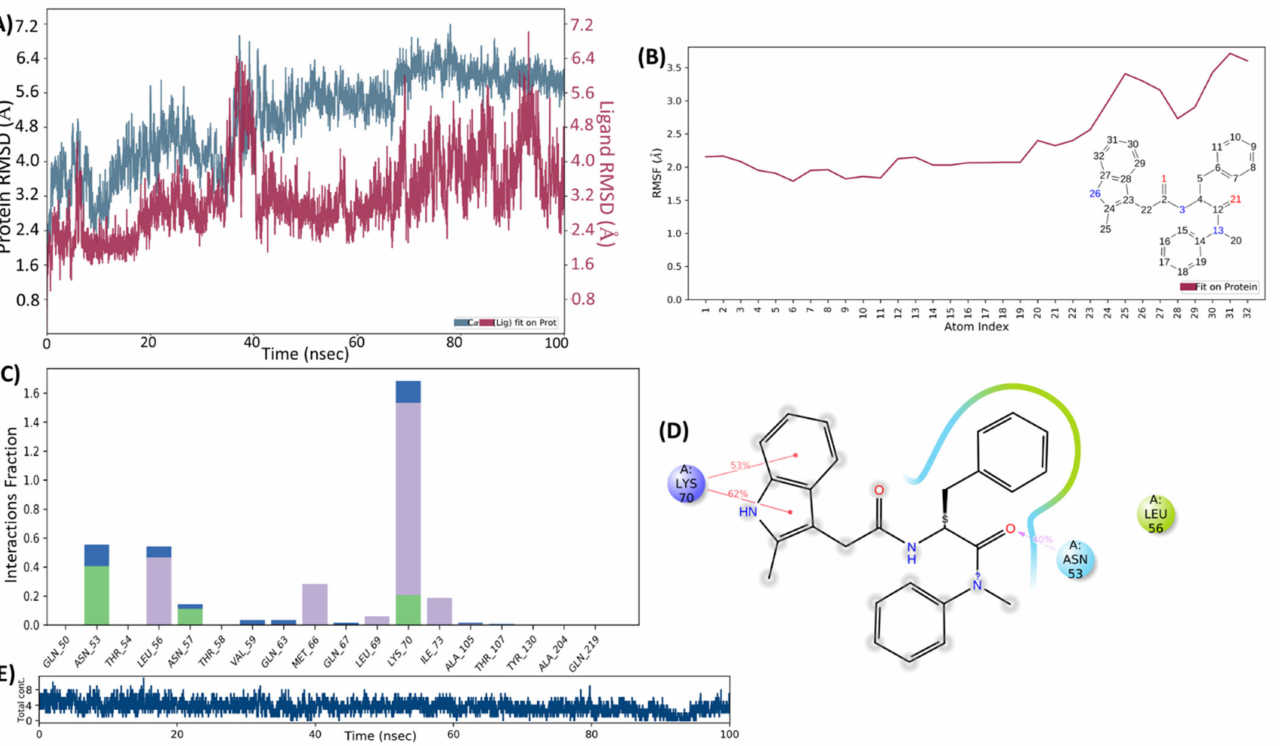
Figure 6. Molecular dynamics simulation process of PF-74 complex with capsid protein. ( A ) RMSD plot for C α of capsid protein (PDB code: 5TSX) in complex with PF-74 ; ( B ) RMSF plots of compound in the CA- PF-74 complex; ( C ) The ratio of amino acid residues to the role of PF-74 ; ( D ) The percentage of interactions in molecular dynamic simulations of PF-74 complex with capsid; ( E ) A timeline representation of the interactions and total contacts (H bonds, hydrophobic interactions, and water bridges) obtained during the molecular dynamics simulations. The panels show the total number of specific contacts the capsid made with the PF-74 throughout the